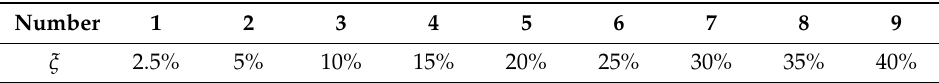
Table 2. Damping ratios ( ξ ) of test.